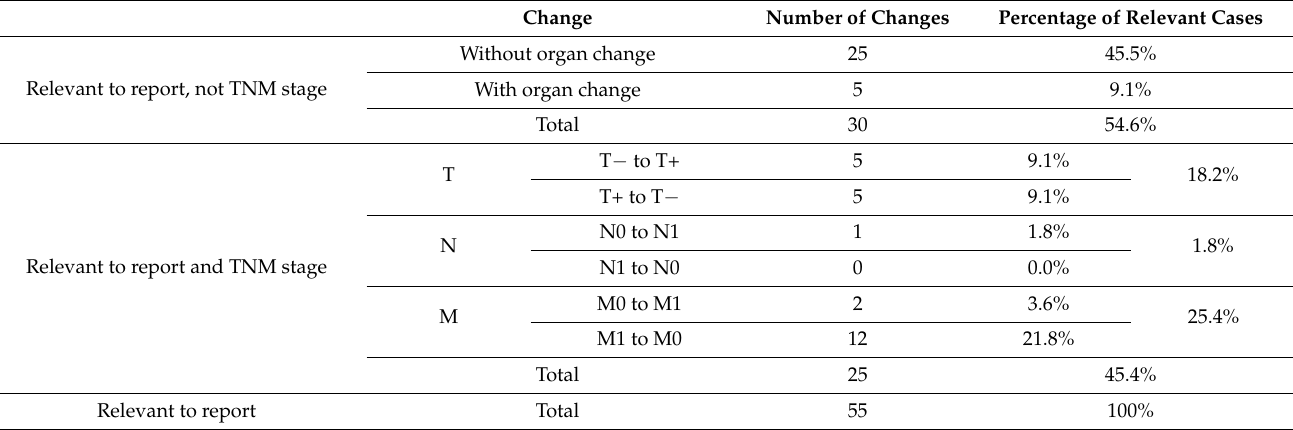
Table 3. Distribution of all 68 Ga-DOTATOC-PET/CT examinations relevant to report.